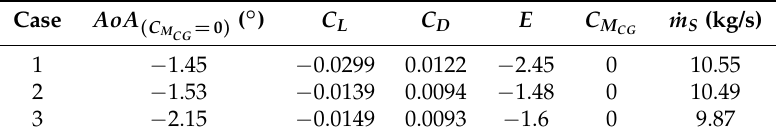
Figure 17. Mass flow rate throughout the scramjet in terms of the angle of attack of the three CFD cases. Table 7. Aerodynamic parameters and mass flow rate for the zero pitching moment condition = 0) of the three CFD ( C M CG